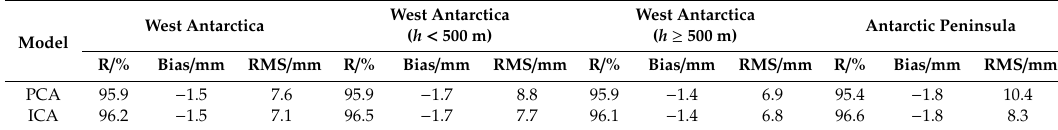
Table 1. Correlation coe ffi cient R, bias, and root mean square (RMS) of the ZTD models and GPS-ZTD.